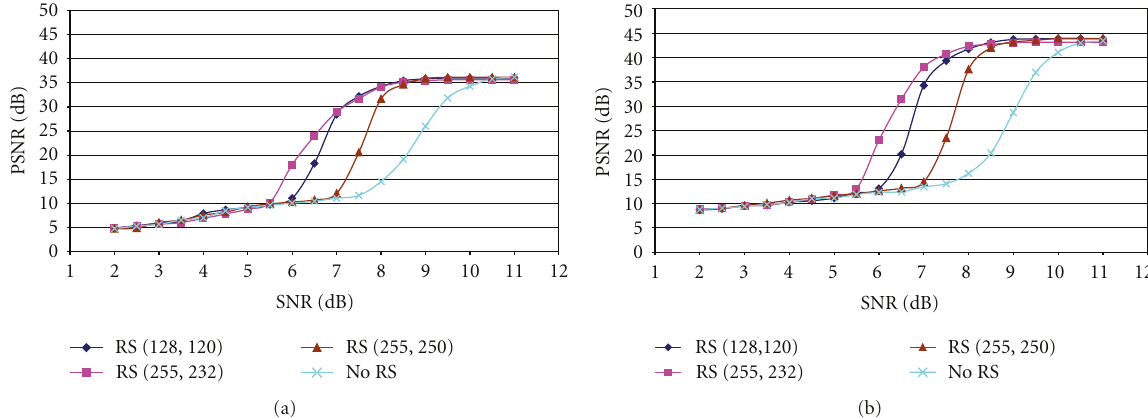
Figure 11: PSNR evolution for “Foreman” and “Akyio” sequences in QCIF resolution over BSC channel for di ff erent protection levels with RS codes.